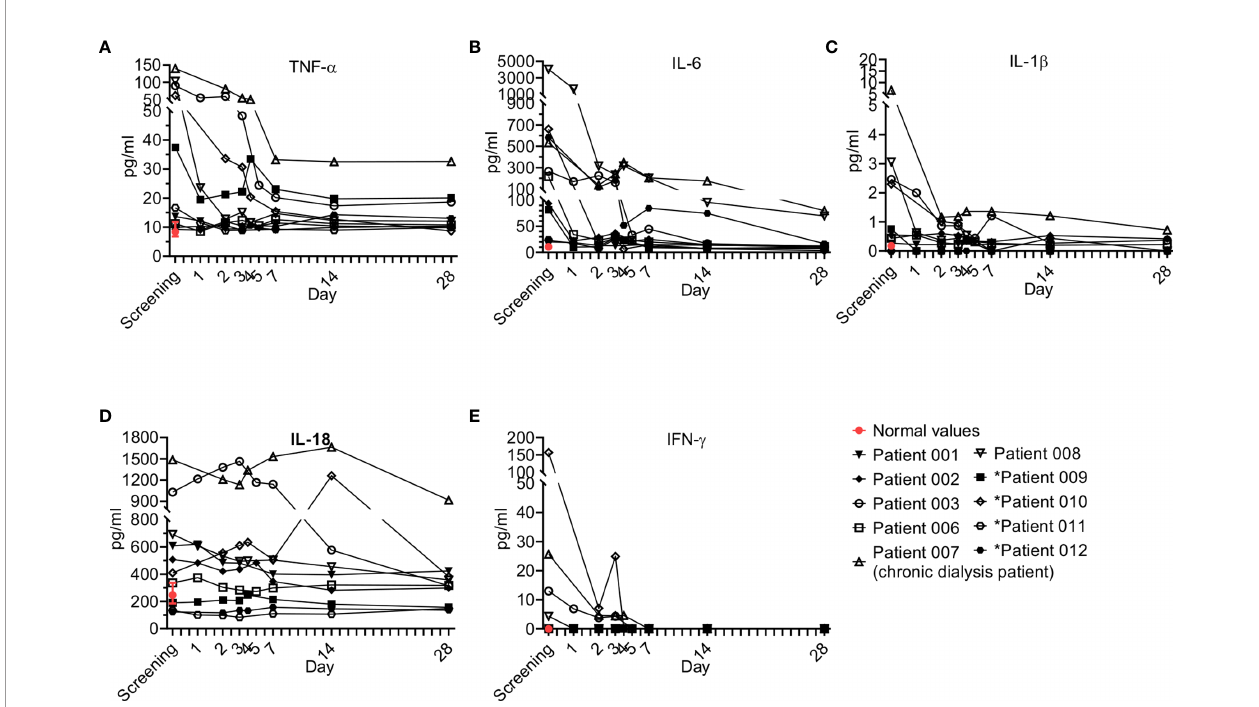
FIGURE 5 | Pro-in fl ammatory cytokine kinetics during sepsis. Serum was obtained from patients at the indicated times and cytokine analysis was performed as described in Methods. The serum of three healthy volunteers was analyzed using the same methods and values are presented as the normal range (median ± range). Serum concentrations of (A) IL-6, (B) TNF- a , (C) IL-1 b , (D) IL-18, and (E) IFN- g are presented. Patients 01 – 08 received one dose of Allocetra-OTS on day 1 and patients 09 – 12 received two doses on days 1 and